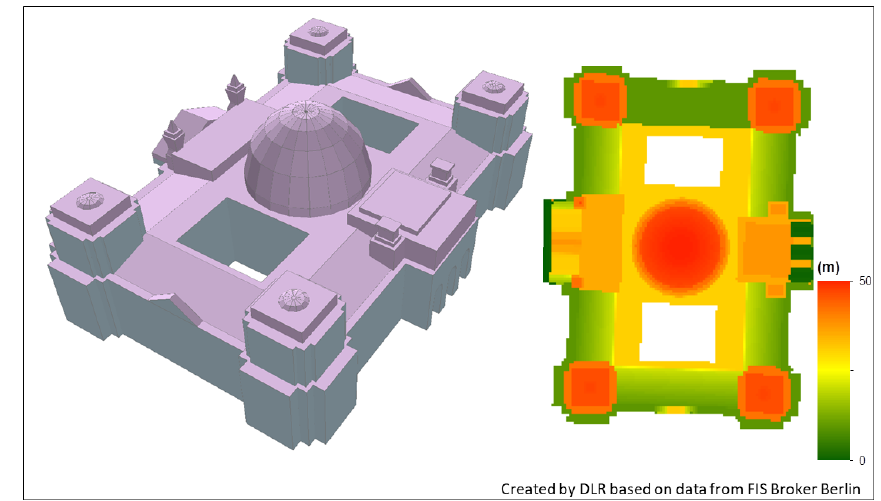
Figure 3. The 3D visualization of the CityGML data of the Reichstag building in Berlin (left) and the derived building height (right). Source: FIS Broker (dl-de/by-2-0: https://www.govdata.de/dl-de/by-2-0, last access: 26 October 2020) CityGML LOD2.